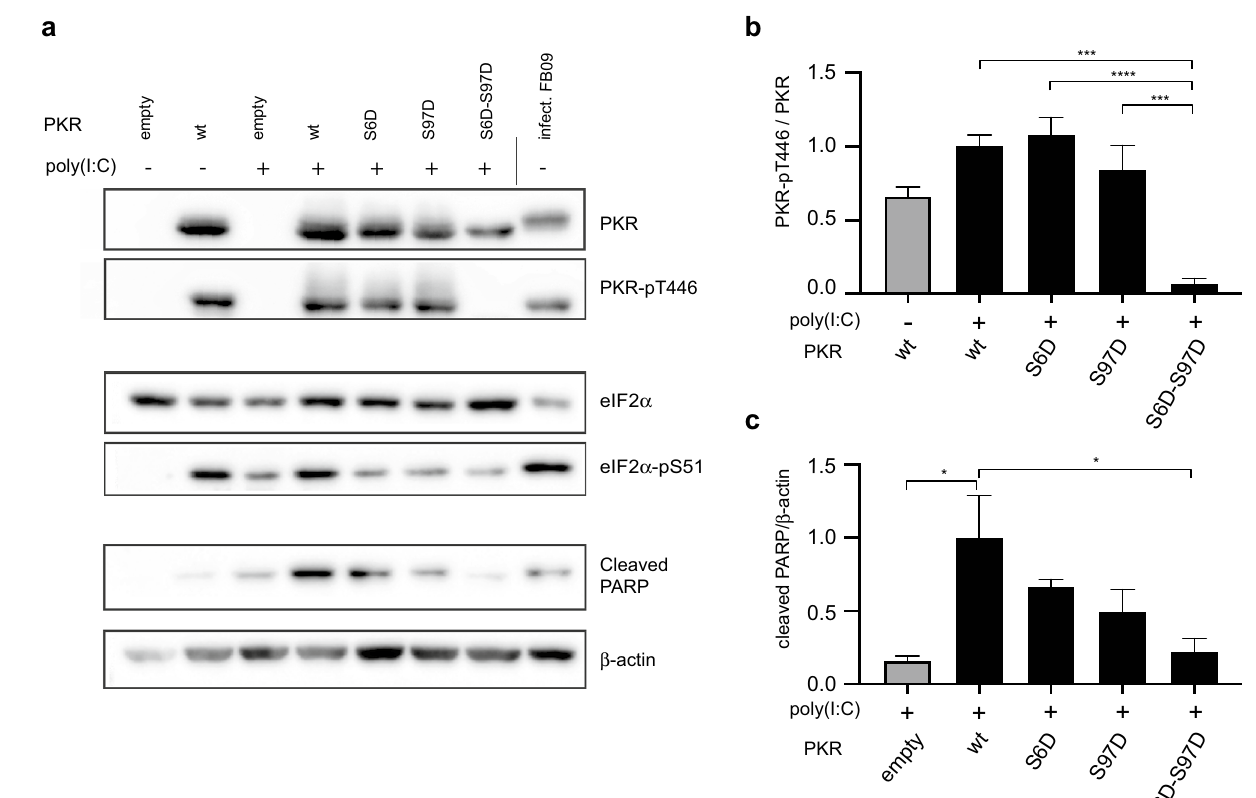
Figure 5. Combination of S6D and S97D phosphomimetic mutations prevents PKR activation by poly(I:C). PKR-KO cells were transfected either with wt PKR or Ser6- and/or Ser97-to-Asp PKR mutants for 40 h. Cells were next transfected with poly(I:C) for 8 h and then lysed for western blot analysis. The FB09 sample (HeLa cells infected with L M60V -mutant TMEV for 12 h) was used as positive control for PKR activation ( a ) Western blot detection of PKR, PKR-pT446, eIF2α, eIF2α-pS51, cleaved PARP and β-actin. ( b ) Quantification of the PKR-pT446 / PKR ratio. (mean ± SEM, n = 4). ( c ) Quantification of apoptosis by the cleaved PARP / β-actin ratio. (mean ± SEM, n = 4). 1-way ANOVA was used for multiple comparisons between poly(I:C)-treated samples. Western blots were quantified by chemiluminescence using a CCD camera (Fusion Solo-S, Vilber)